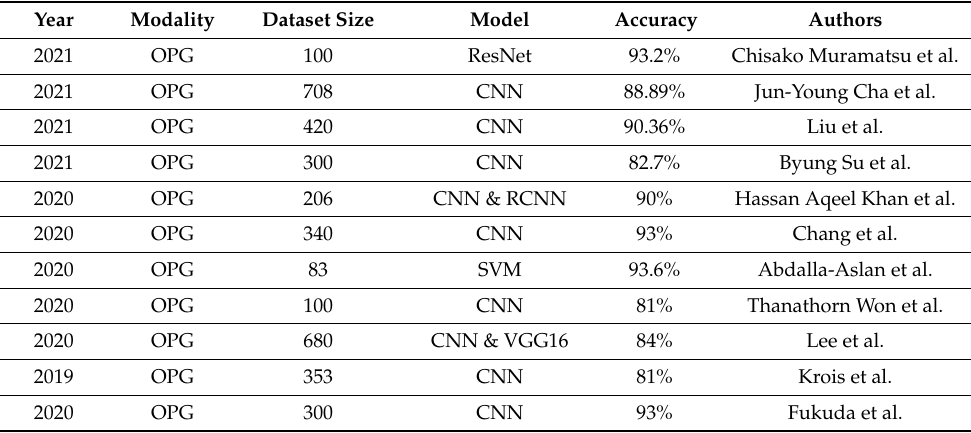
Table 1. Existing models for dental